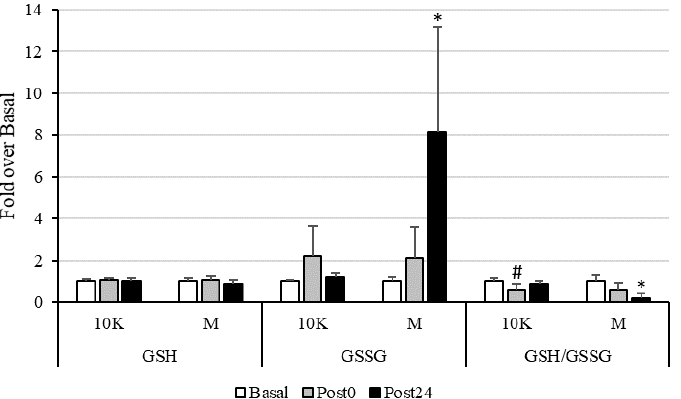
Figure 2. Reduced (GSH) and oxidized (GSSG) glutathione concentrations, as well as GSH/GSSG ratio, expressed as fold over Basal, trough the different races and timepoints. 10K: 10 km race; M: Marathon race. Basal: sample collected within 1 h before each race; Post0: sample collected within 10 min after the race; Post24: sample collected 24 h after Basal. * Significantly different ( p < 0.05) from Basal and Post0; # Significantly different ( p < 0.05) from Basal and Post24. Data are presented as mean ± standard deviation. Sample size, N = 9.